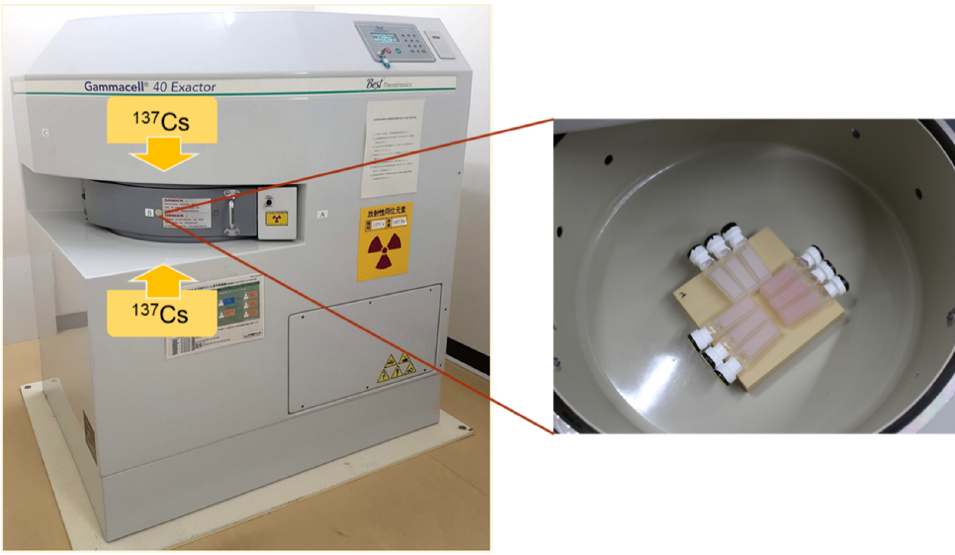
Figure 1. Experimental setup for irradiation using 137 Cs source γ -rays; 3 samples each were irradiated with 5, 10 and 20 Gy (for water) with a dose rate of 0.75 Gy min − 1 .